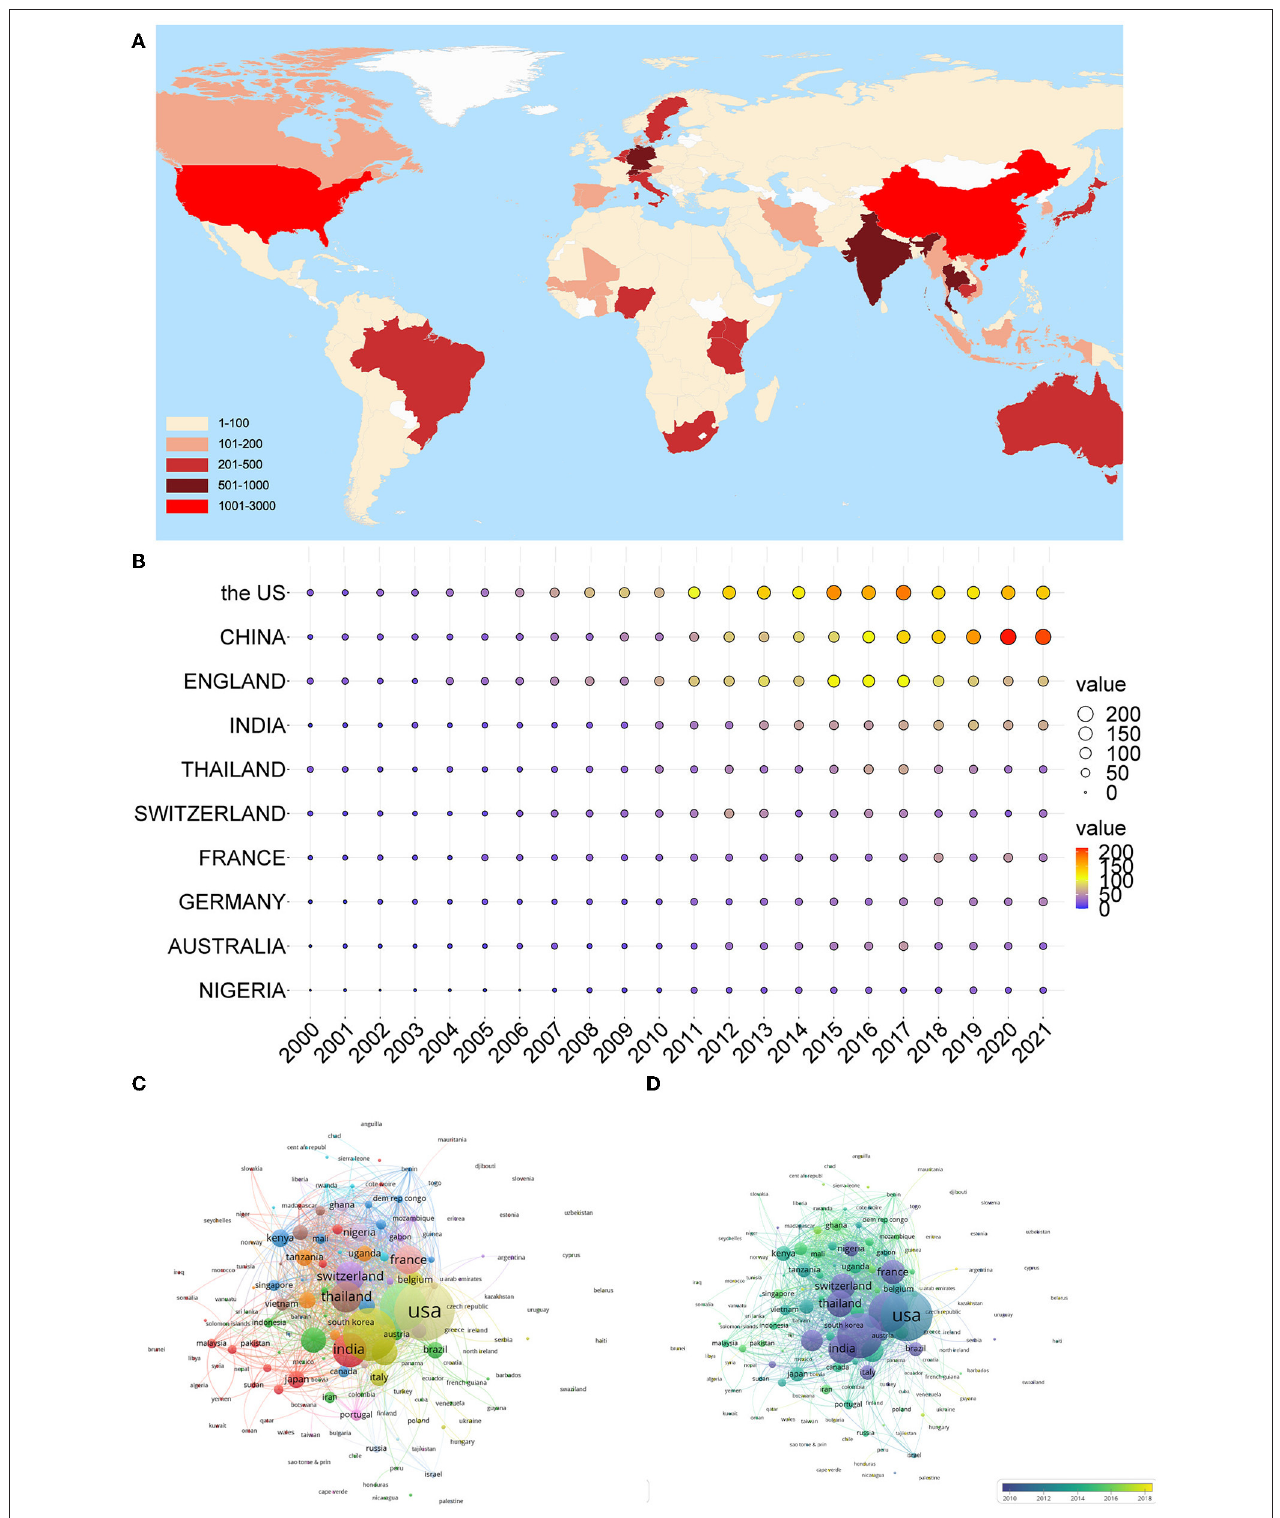
FIGURE 3 | Countries in artemisinin research. (A) Geographical distribution of global output; (B) annual output trend of the top 10 productive countries; (C) visual cluster analysis of cooperation among countries; and (D) timeline visualization of cooperation among countries.